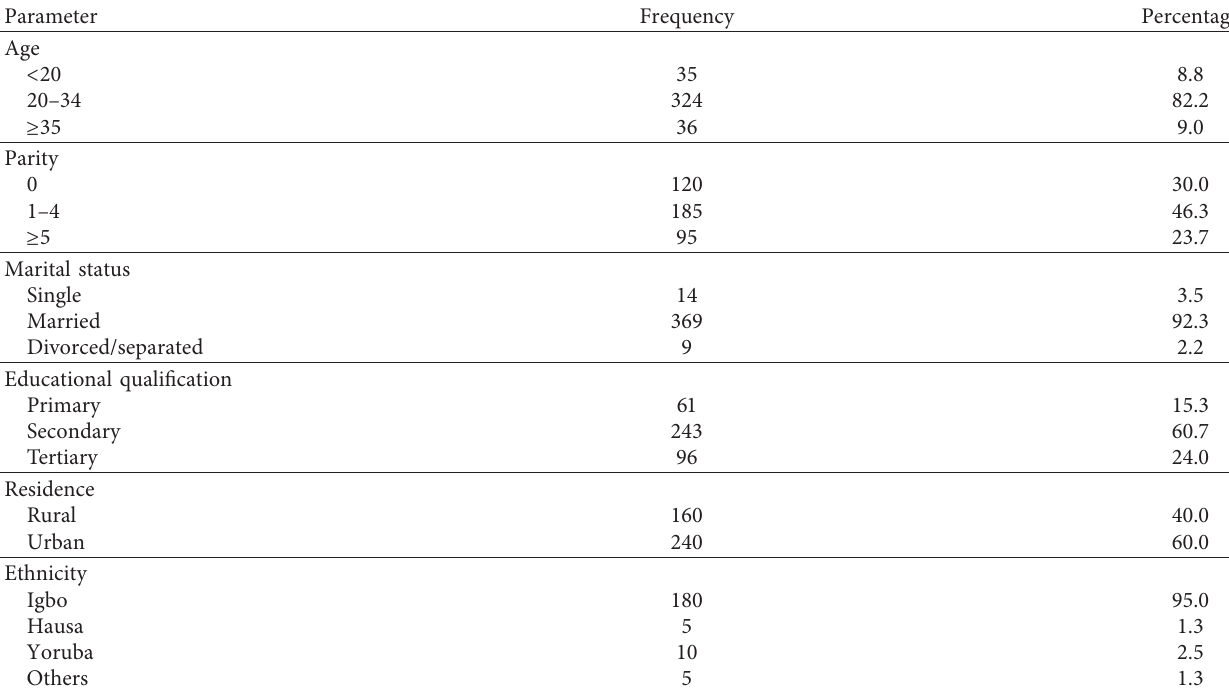
Table 1: Sociodemographic status of